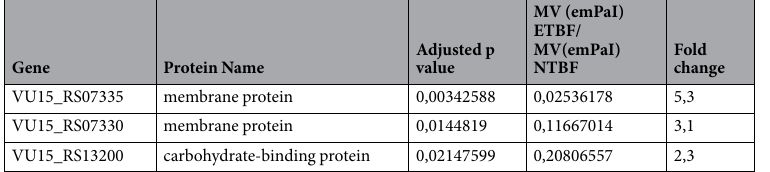
Table 1. Comparative proteomic analysis of proteins identified in ETBF and NTBF OMVs. Mean value (MV) of emPaI(ETBF) and emPaI(NTBF) indexes were calculated for three biological repeats. Fold change is the log 2 of MV of emPaI(ETBF) and emPaI(NTBF).